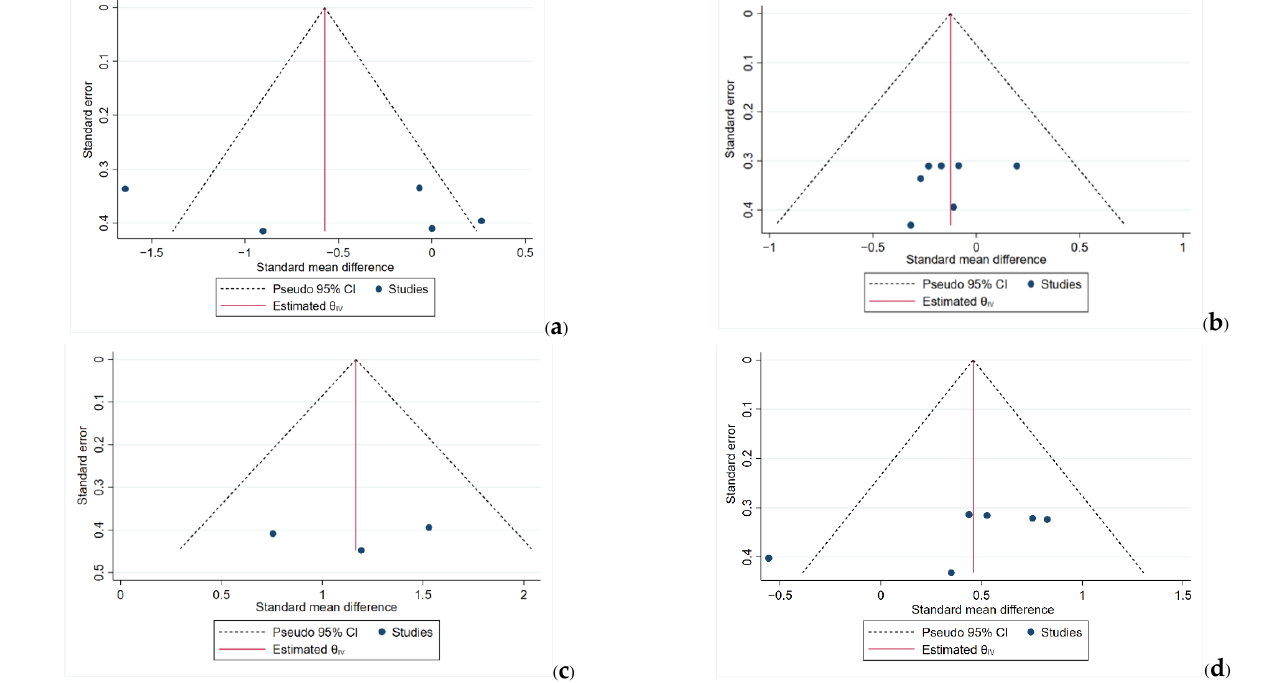
Figure 6. Funnel plots; ( a ) the differences in oxygen saturation after a high physical workload; ( b ) the differences in oxygen saturation after a low-to-moderate physical workload; ( c ) the differences in partial pressure carbon dioxide after a high physical workload; ( d ) the differences in partial pressure carbon dioxide after a low-to-moderate workload.